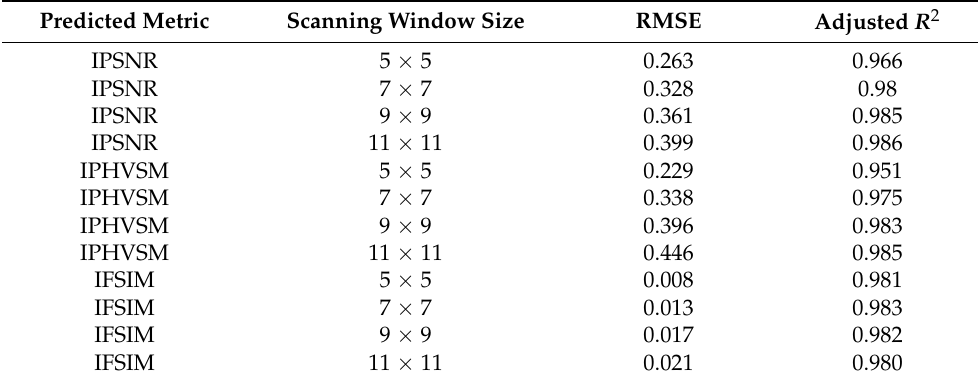
Table 2. Cross-dataset evaluation for the same Sentinel-2 data, channel #11. Predicted